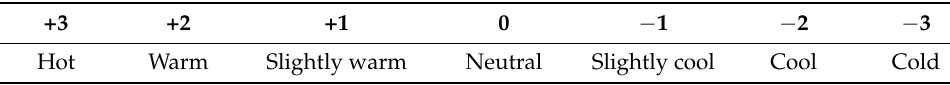
Table 4. Thermal sensation voting questionnaire.